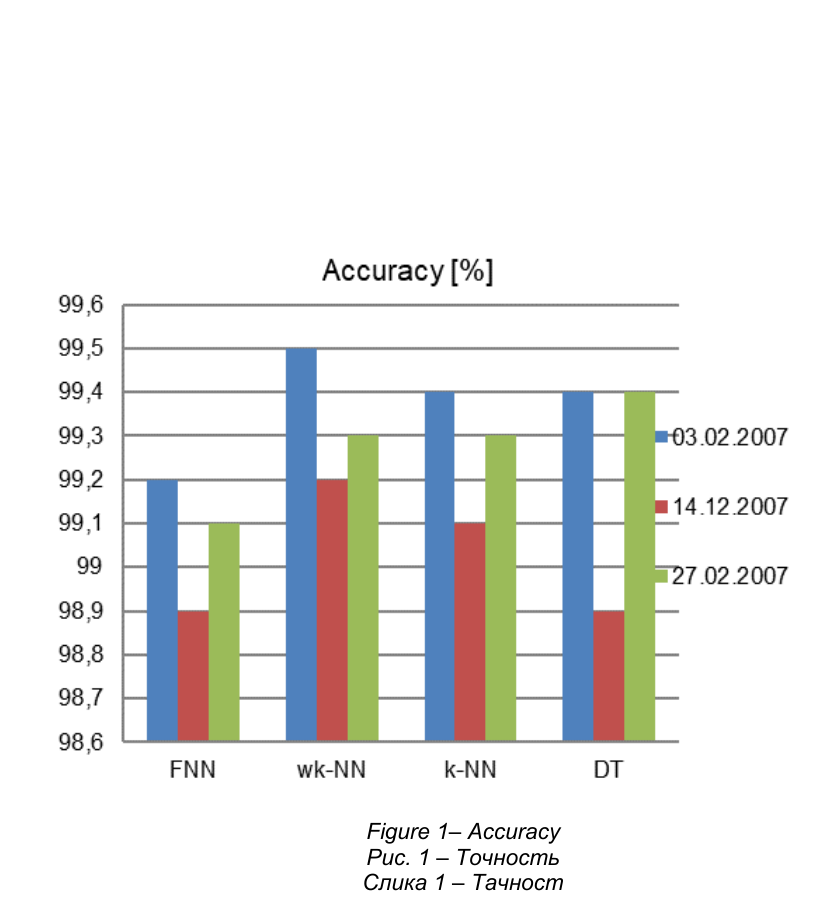
Figure 1– Accuracy Рис . 1 – Точность Слика 1 –